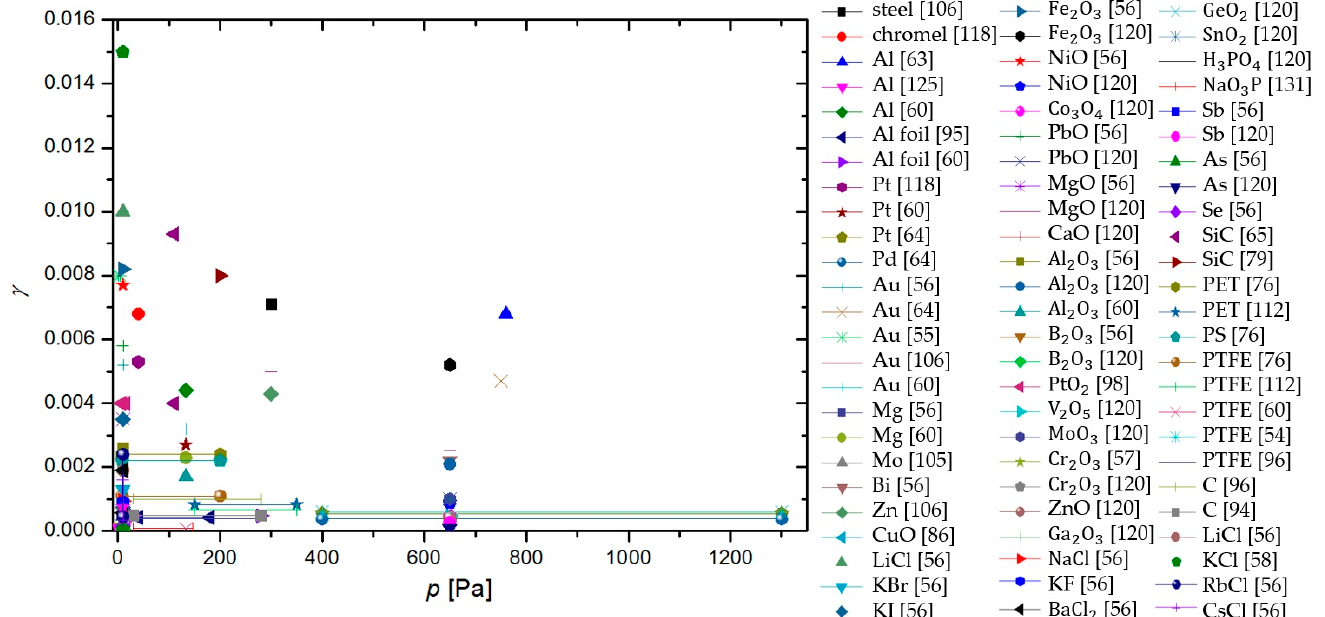
Figure 24. Recombination coefficient ( γ ) of neutral oxygen atoms versus pressure ( p ) for various inert surfaces.